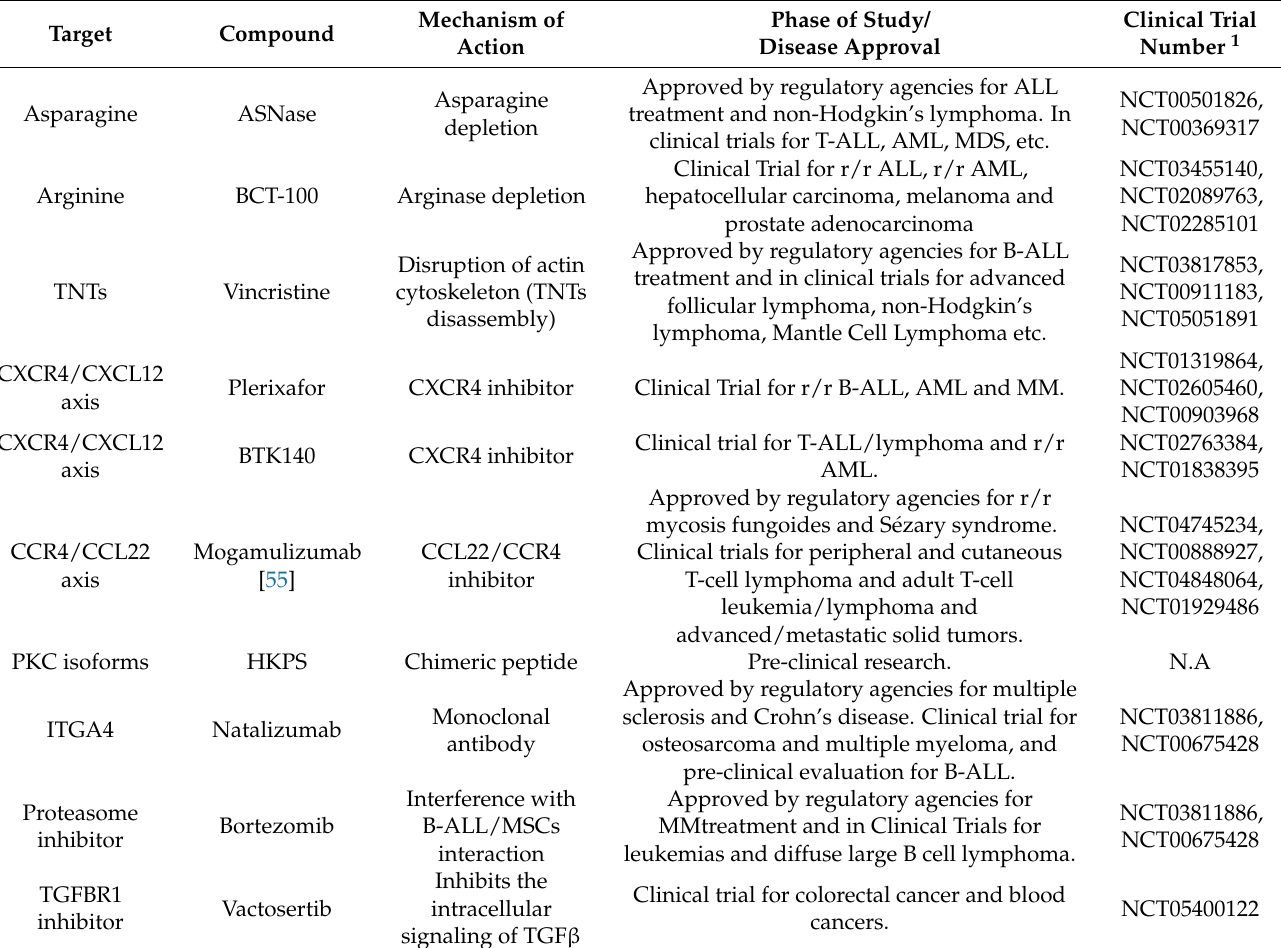
Table 1. Possible therapeutic approaches for targeting the B-cell acute lymphoblastic leukemia (B-ALL) bone marrow